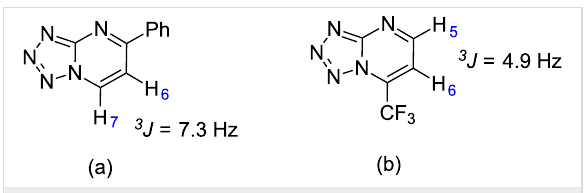
The formation of 7-trihalomethyl-substituted (R = CF 3 and CCl 3 ) tetrazolo[1,5- a ]pyrimidine when β -enaminones were reacted with 5-aminotetrazole showed that the structure of the R group affects the regiochemistry of the products